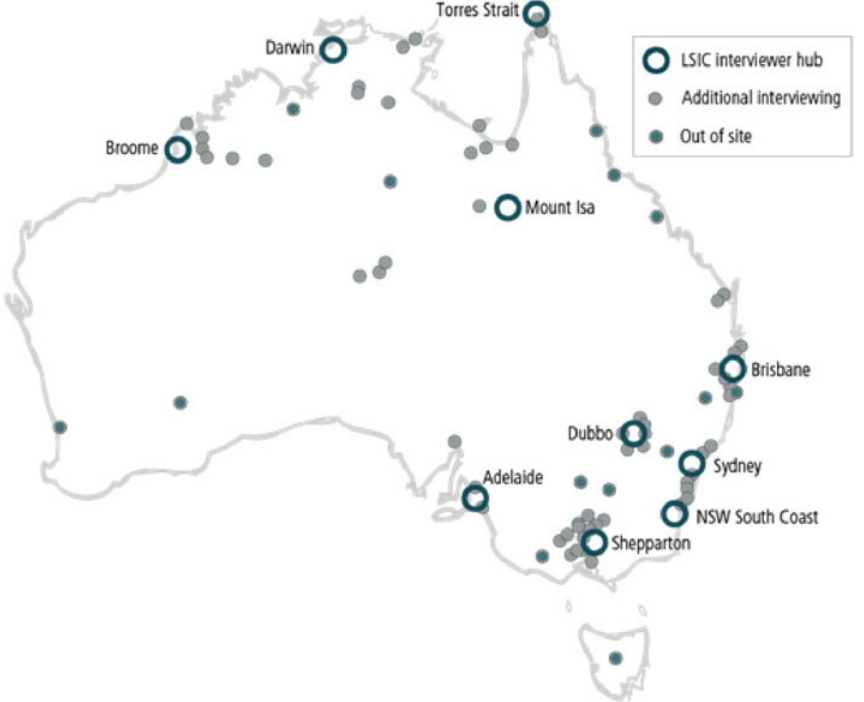
Fig. 1. Longitudinal Study of Indigenous Children Data Collection Sites (Kneebone et al .,